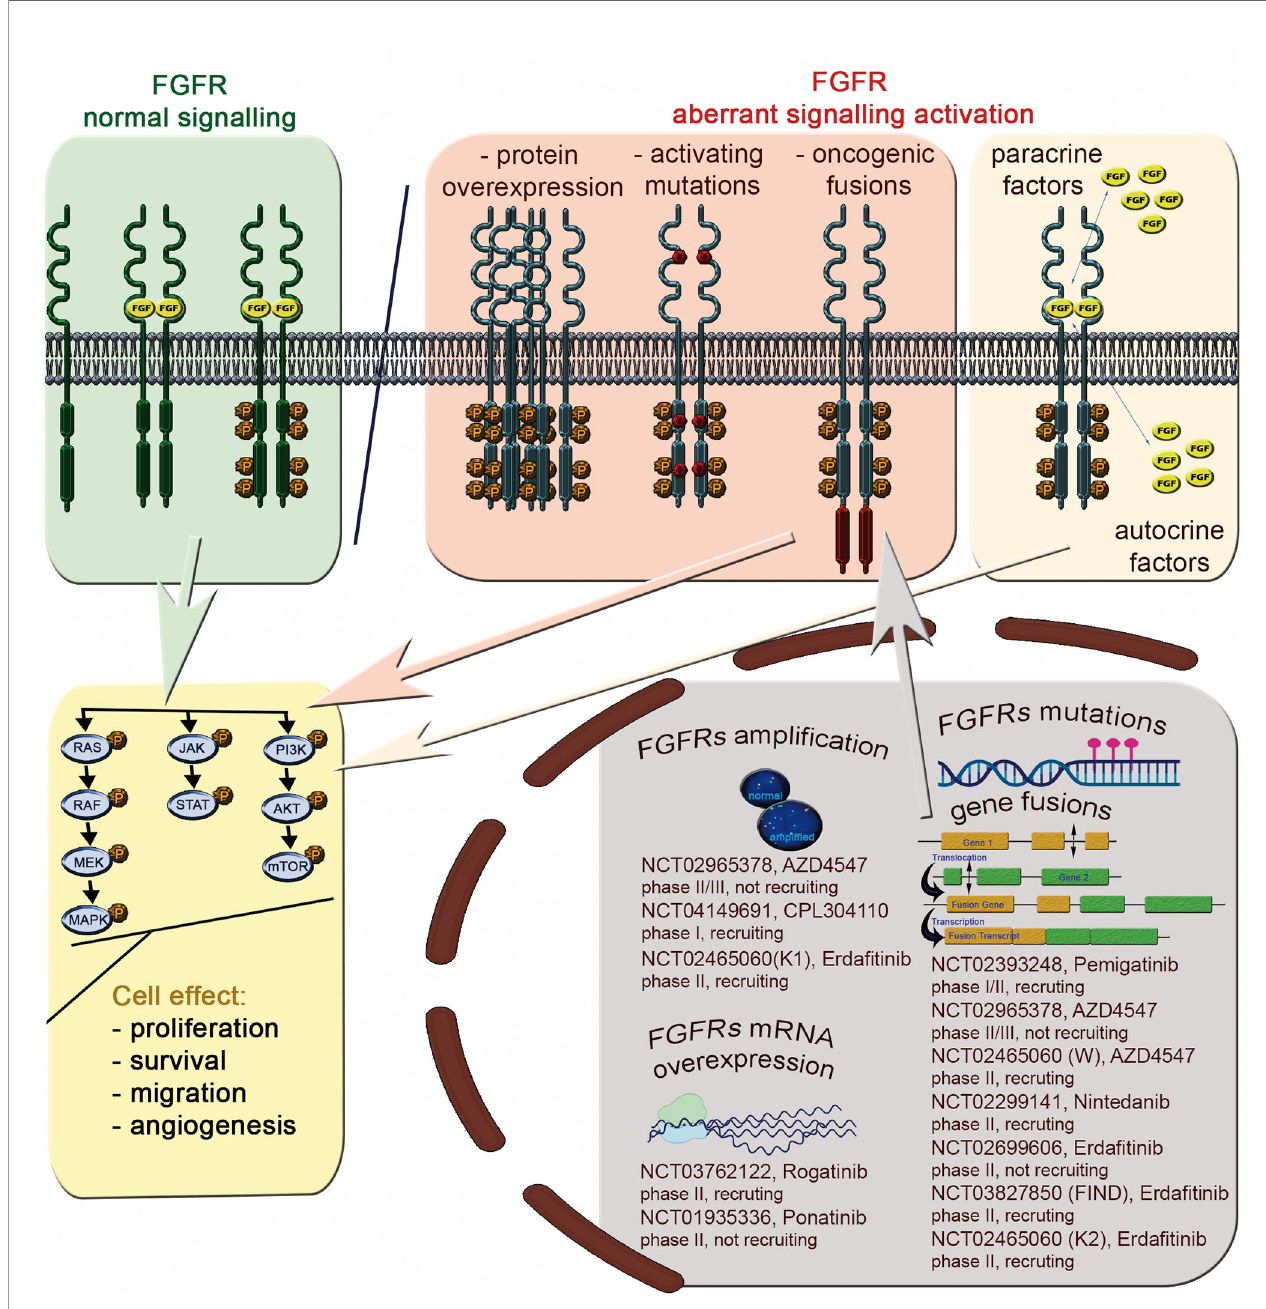
FIGURE 2 | The FGFR signaling pathway and aberrations with potential as predictive biomarkers for FGFRi treatment of